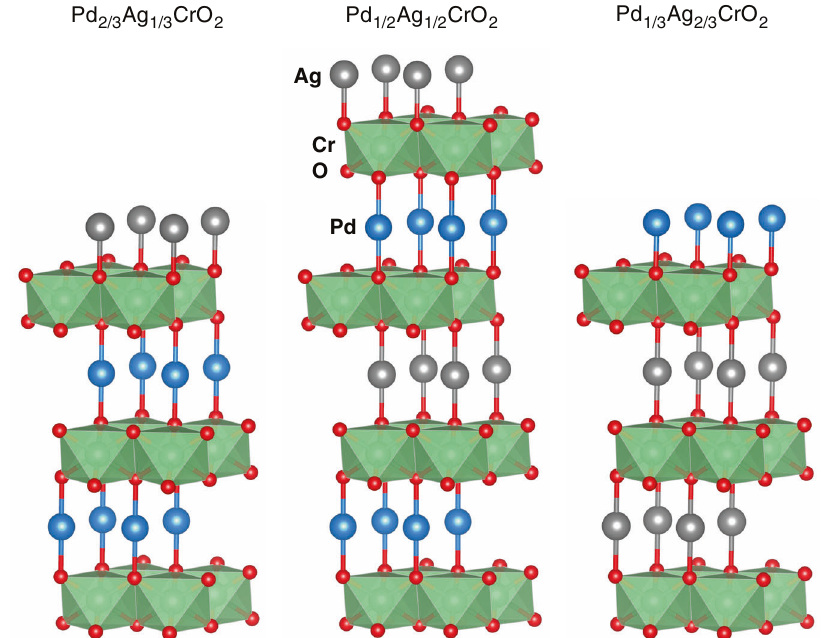
Fig. 7 Crystal structures of the designed out-of-plane heterostructures. Pd 2/3 Ag 1/3 CrO 2 , Pd 1/2 Ag 1/2 CrO 2 and Pd 1/3 Ag 2/3 CrO 2 (from left to right) result from different stackings along the c -axis. Pd: blue, Ag: grey, Cr: green and O: red. From Ref. 72 also instructive for the understanding of the hidden-Mott state, we performed calculations for hypothetical RhCrO 2 , using the lattice parameters and Hubbard U of PdCrO 2 . The results are shown in Fig. 9. The DFT band structure at lower energy exhibits the expected upward shiftings of the dispersions compared to the Pd compound. The fi lling of the Cr- t 2 g dominated bands is hence smaller, close to unity (i.e., α ~ 1/6). Surprisingly, interactions still establish a near hidden-Mott state with a half- fi lled Cr- t 2 g subshell. This underlines the signi fi cant coupling between the A layer and the CrO 2 planes. The fermiology becomes twofold in the Rh compound, associated with a shrinking of the original warped